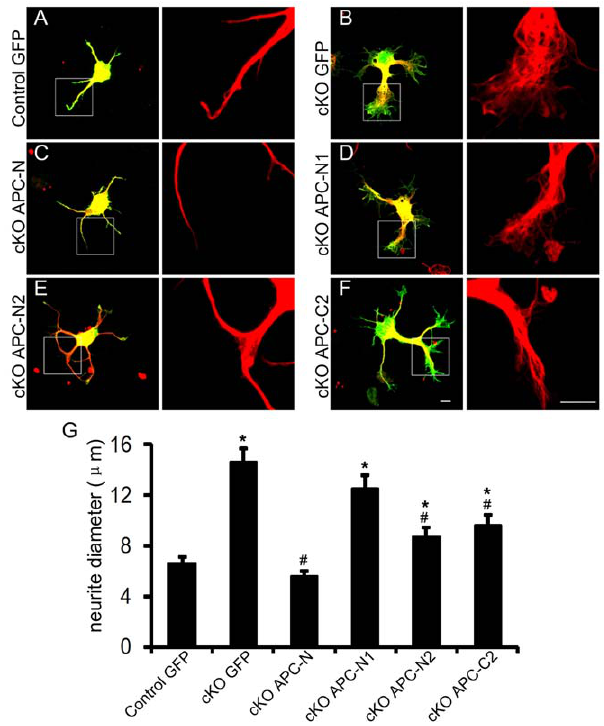
Figure 6. N-terminus of APC rescues microtubule debundling phenotype in APC deleted neurons. (A–F). Neurons were electroporated with GFP or APC truncation mutants after dissociation from E14.5–E15.5 embryo cortices. After 24 hours double label immunofluoresence was performed with antibodies against a -tubulin (red) and GFP (green). Right panels are the magnified views of neurites labeled with microtubule from left panels. (G) Neurite diameters measured from the thickest point. *: P , 0.05, when compared with control neurons expressing GFP alone. # : P , 0.05, when compared with APC deficient neurons expressing GFP alone. Note that expression of APC-N fully rescues the debundling phenotype. n=30 neurons for each condition. Scale bars: 5 m